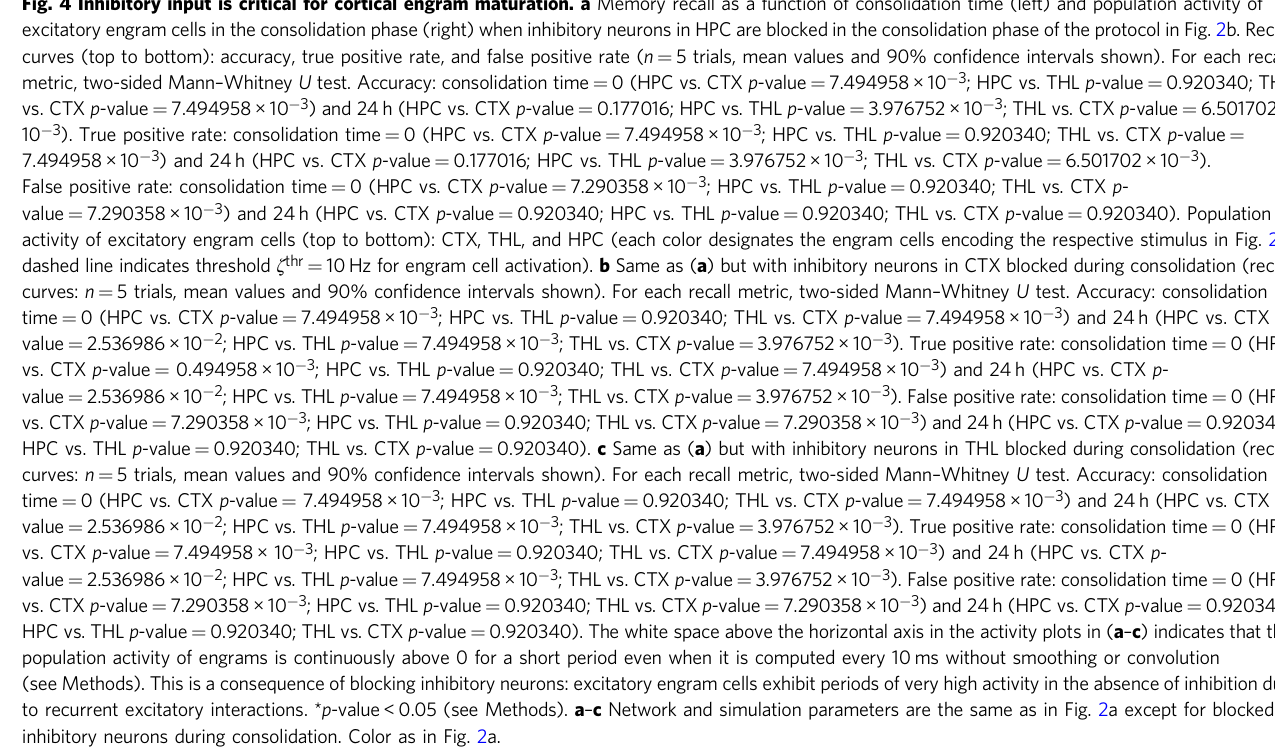
population activity of engrams is continuously above 0 for a short period even when it is computed every 10ms without smoothing or convolution (see Methods). This is a consequence of blocking inhibitory neurons: excitatory engram cells exhibit periods of very high activity in the absence of inhibition due to recurrent excitatory interactions. * p -value<0.05 (see Methods). a – c Network and simulation parameters are the same as in Fig. 2a except for blocked inhibitory neurons during consolidation. Color as in Fig. (Fig. 4a and Supplementary Fig. 23a). Blocking inhibitory neu- Supplementary Fig. 23c). In each of the previous simulations, rons in CTX also tampers with CTX engram dynamics and the subcortical-cortical coupling of engram reactivations (Fig. 4b and Supplementary Fig. 23b). These results are aligned with previous fi ndings that showed that blocking parvalbumin-positive inter- neurons either in HPC or CTX decoupled oscillations in these regions in consolidation periods and disrupted systems consolidation 54 . We then block inhibitory neurons in THL and this also prevents engram cell maturation in CTX and the cou- pling of engram reactivations in the network (Fig. 4c and experiments that blocked parvalbumin-positive interneurons